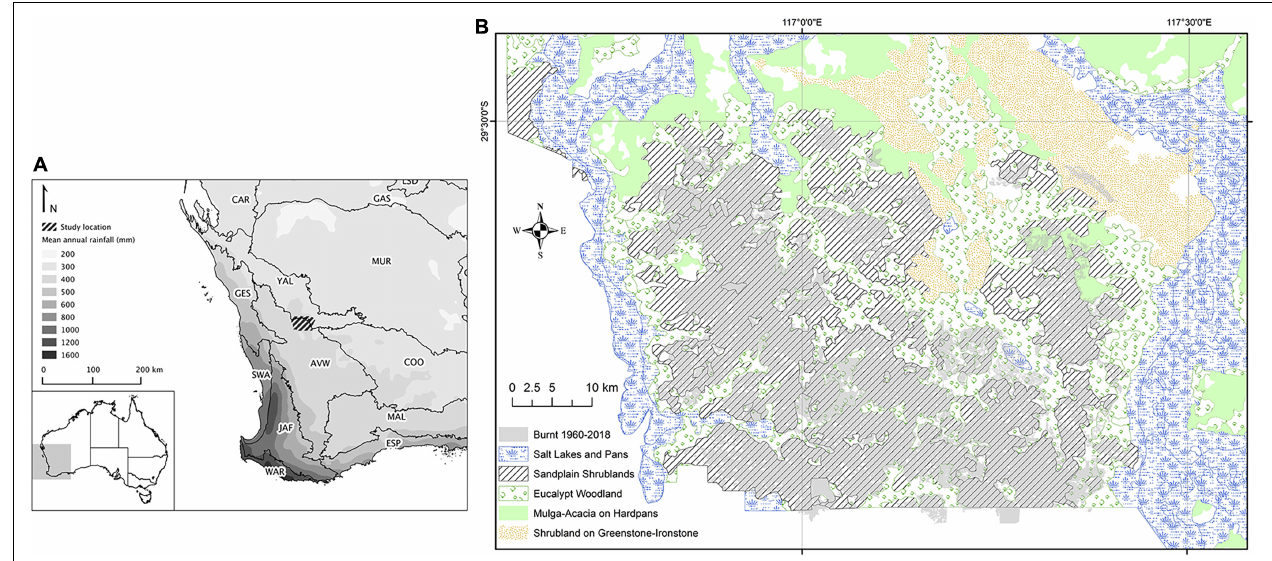
FIGURE 1 | Maps of study area showing: (A) location within Australia and region relative to average annual rainfall and Australian bioregions, and (B) areas burnt 1960–2018 (shaded in gray) in relation to major vegetation types as per legend.